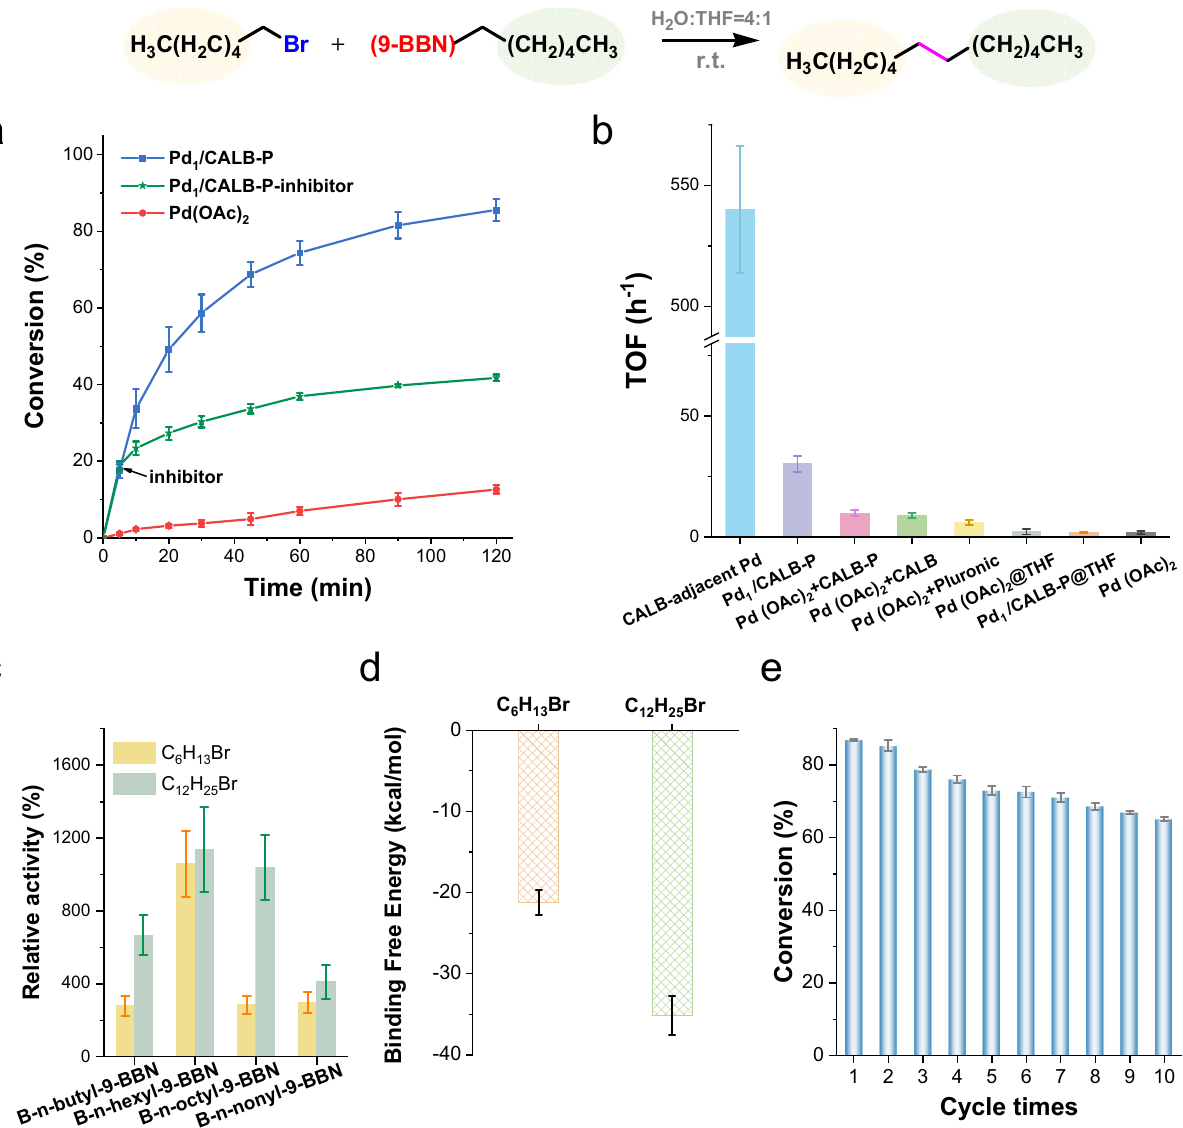
Fig. 3 Catalytic performance of Pd1/CALB-P in alkyl – alkyl cross-coupling reactions. a Reaction scheme and the conversion. b TOF of Pd 1 /CALB-P and Pd(OAc) 2 in the cross-coupling of 1-bromohexane and B -n-hexyl-9-BBN in H 2 O:THF (4:1) or THF. Conditions: 30 mM 1-bromohexanes, 100 mM B -n-alkyl- 9-BBN, and 6.7 mol% Pd. c Activity of Pd 1 /CALB-P in the cross-coupling reactions using 1-bromohexane or 1-bromododecane as the electrophile and B -n- butyl-9-BBN, B -n-butyl-9-BBN, B -n-butyl-9-BBN, or B -n-butyl-9-BBN as the nucleophile, compared with Pd(OAc) 2 (reference activity as 100%) at the same amount of Pd. d The calculated binding free energies of the enzyme-substrate complex. e Conversions in ten cycles for the cross-coupling of 1-bromohexane and B -n-hexyl-9-BBN reaction using Pd 1 /CALB-P as the catalyst in H 2 O:THF (4:1). Each data point and error bar represent the mean and standard deviation from at least three independent washing with toluene (5 mL× 3), the precipitated Pd 1 /enzyme – P was then washed by ethanol (5mL ×3) and resuspended in deionized water (5 mL). The powder of the Pd 1 /enzyme – P was obtained by lyophilization and stored at 4 °C.